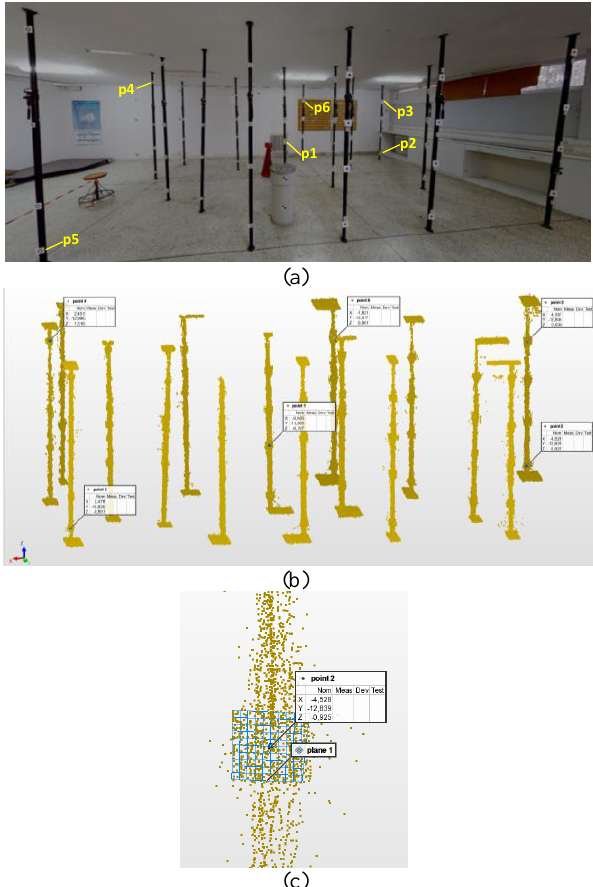
Figure 9. Photogrammetric test field: (a) image; (b) targets in BLK2GO cloud; (c) target plane fit